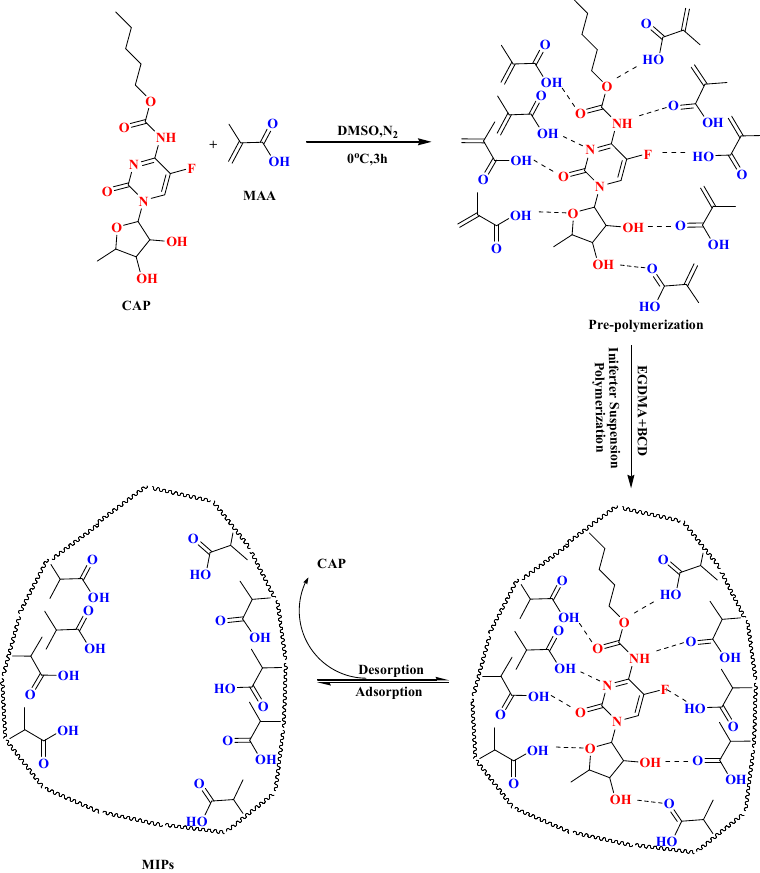
Figure 1. CPA-imprinted polymer microspheres were synthesized via a combined suspension- iniferter polymerization method.